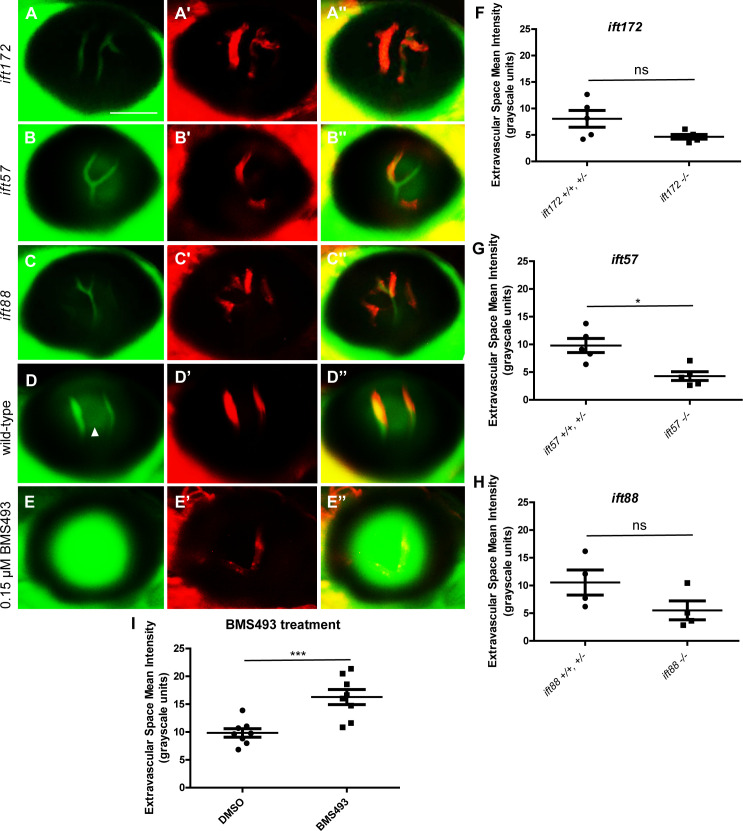
IFT mutant fish develop and maintain a functional BRB.Fluorescent micrographs of the hyaloid vessels in live 6 dpf IFT mutant and wild-type Tg(l-fabp:DBP-EGFP;flk1:mCherry) fish. In the ift172 (A), ift57 (B), and ift88 (C) mutants and wild-type larvae (D), the DBP-EGFP- associated signal (green) localizes within the mCherry-tagged vessels (red), indicating that the BRB is intact. Some autofluorescence (likely from the lens) is observed in the areas outside of the hyaloid vessels (arrowhead in D). (E) As an example of BRB breakdown, Tg(l-fabp:DBP-EGFP;flk1:mCherry) embryos were treated with 0.15 μM BMS493, an inhibitor of retinoic acid signaling, from 2 dpf until 7 dpf. Scale bars = 50 μm. No increase in the Extravascular Space Mean Intensity was observed in the eyes of 6 dpf ift172 (F), ift57 (G), or ift88 (H) fish compared to their wild-type siblings, confirming that the IFT mutant fish do not exhibit increased leakage of DBP-EGFP outside of their hyaloid vessels. Interestingly, the Ift mutant fish actually trend towards a decreased level of autofluorescence in the extravasal space (* p < 0.05, ns = not significant, by Student’s t-test). To confirm the ability of this measurement technique to detect BRB leakage in larval fish, the Extravascular Space Mean Intensity of 7 dpf BMS493-treated fish was measured and compared to that of their DMSO (vehicle)-treated siblings (I) (*** p < 0.005, by Student’s t-test).